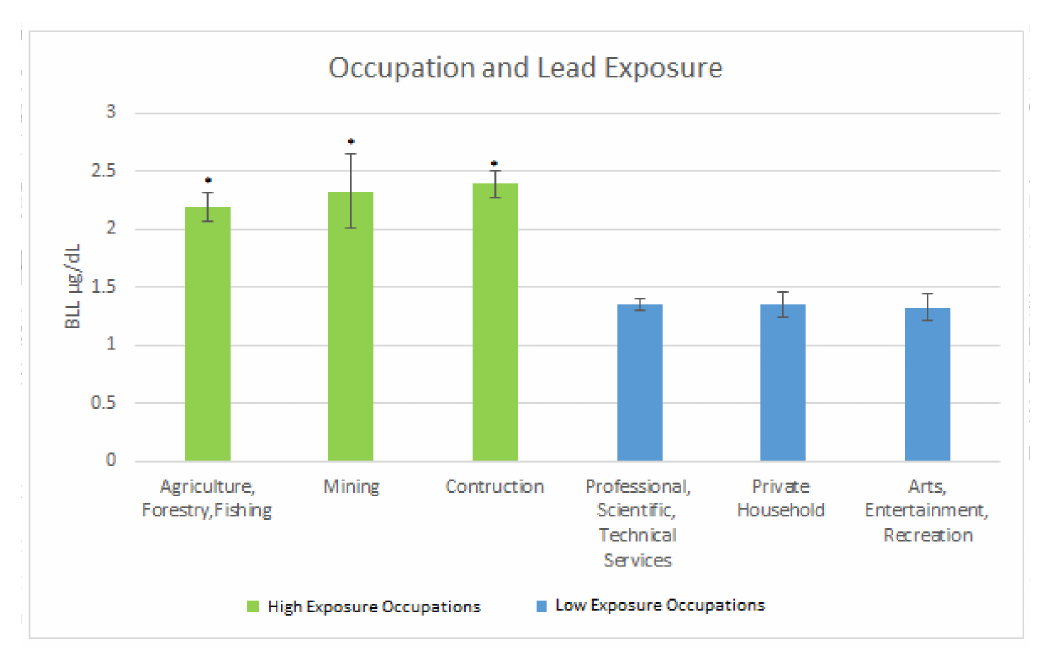
Figure 1. Occupation and Lead Exposure. * Significant difference between high exposure occupations as compared to low exposure